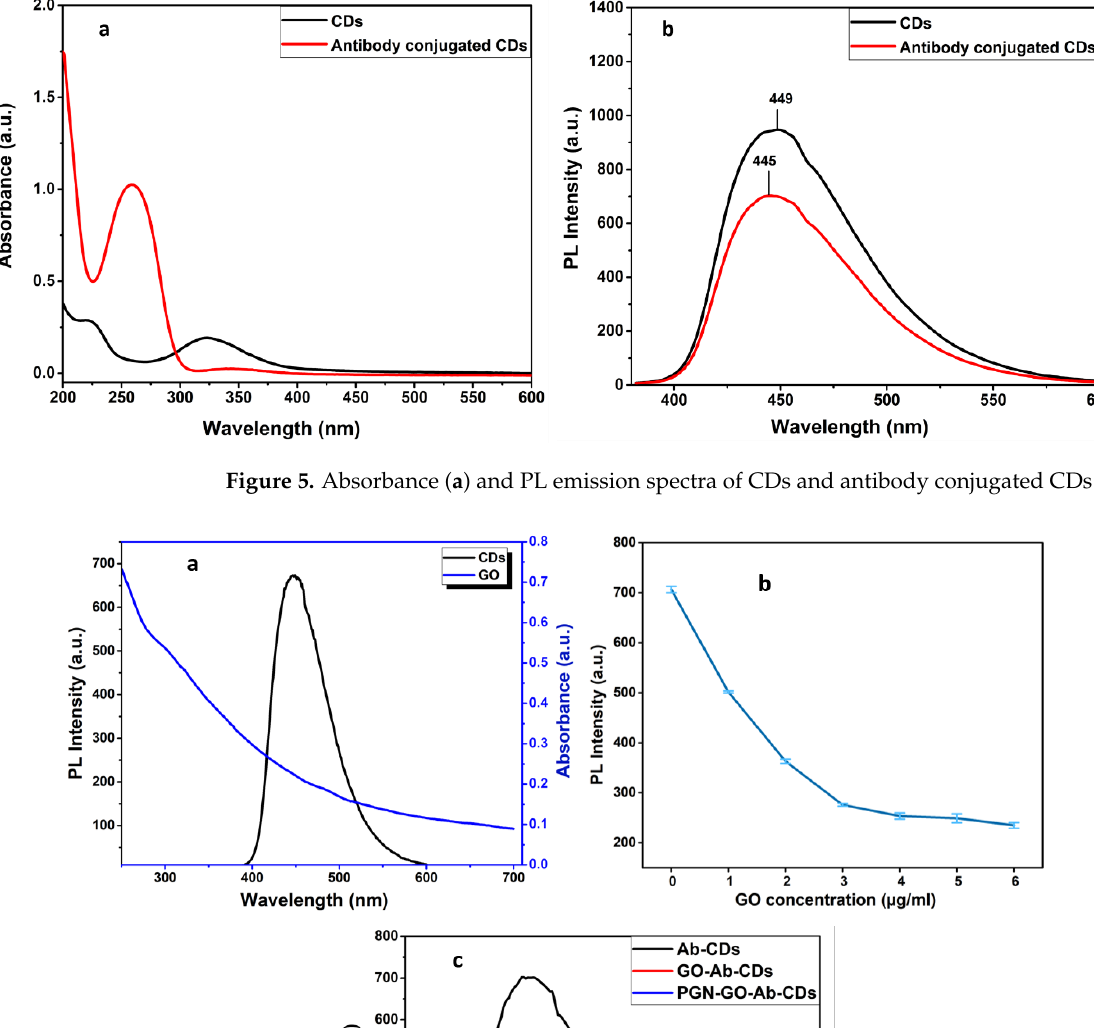
8 of 13 Figure 4. UV-PL graph of CDs and inset images of as-prepared pale-yellow coloured carbon dots solution in normal and UV light ( a ) and XRD pattern of CDs ( b ). The confirmation of binding the antibodies to the functional groups bearing CDs is well obtained by the UV-Vis and PL spectral analysis. Figure 5a suggests the absorption band is around 260 nm, present in CDs – antibody complexes, which is ascribed by the amino acids of the antibodies. Concentration of conjugated antibody on CDs is also esti- mated from the UV graph [33] (Supplementary data). Subsequently, Figure 5b indicates the decreased PL intensity with a slight blue shift ~5 nm attributing to the existence of a proteinaceous layer of conjugated antibodies. In addition, the FTIR spectra of the antibody conjugated N-doped CDs (Ab – CDs) showed broad vibration bands at 3444 – 3477 and 3235 cm −1 corresponding to the functional groups, O – H and N – H stretching respectively. The peaks observed at 2726 – 2928, 2071 – 2328, 1627 and 1601 cm −1 are due to the stretching of the C – H bond, the nitrile bond C ≡ N, the amide bond C=O and the N – H bending, respec-